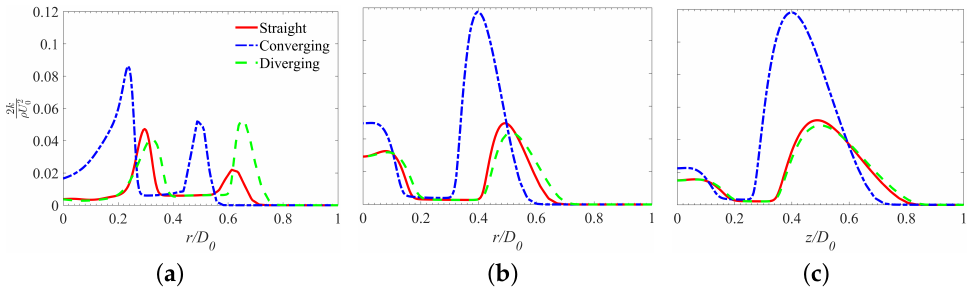
at ( a ) H = 0.5, ( b ) H = 2, and ( c ) H = 4. 2